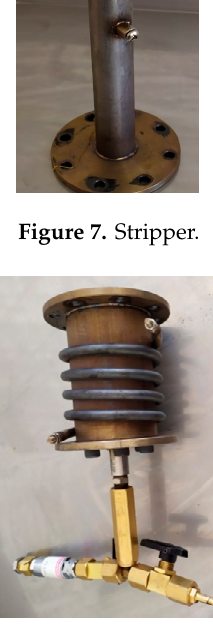
Appl. Sci. 2020 , 10 , x FOR PEER REVIEW